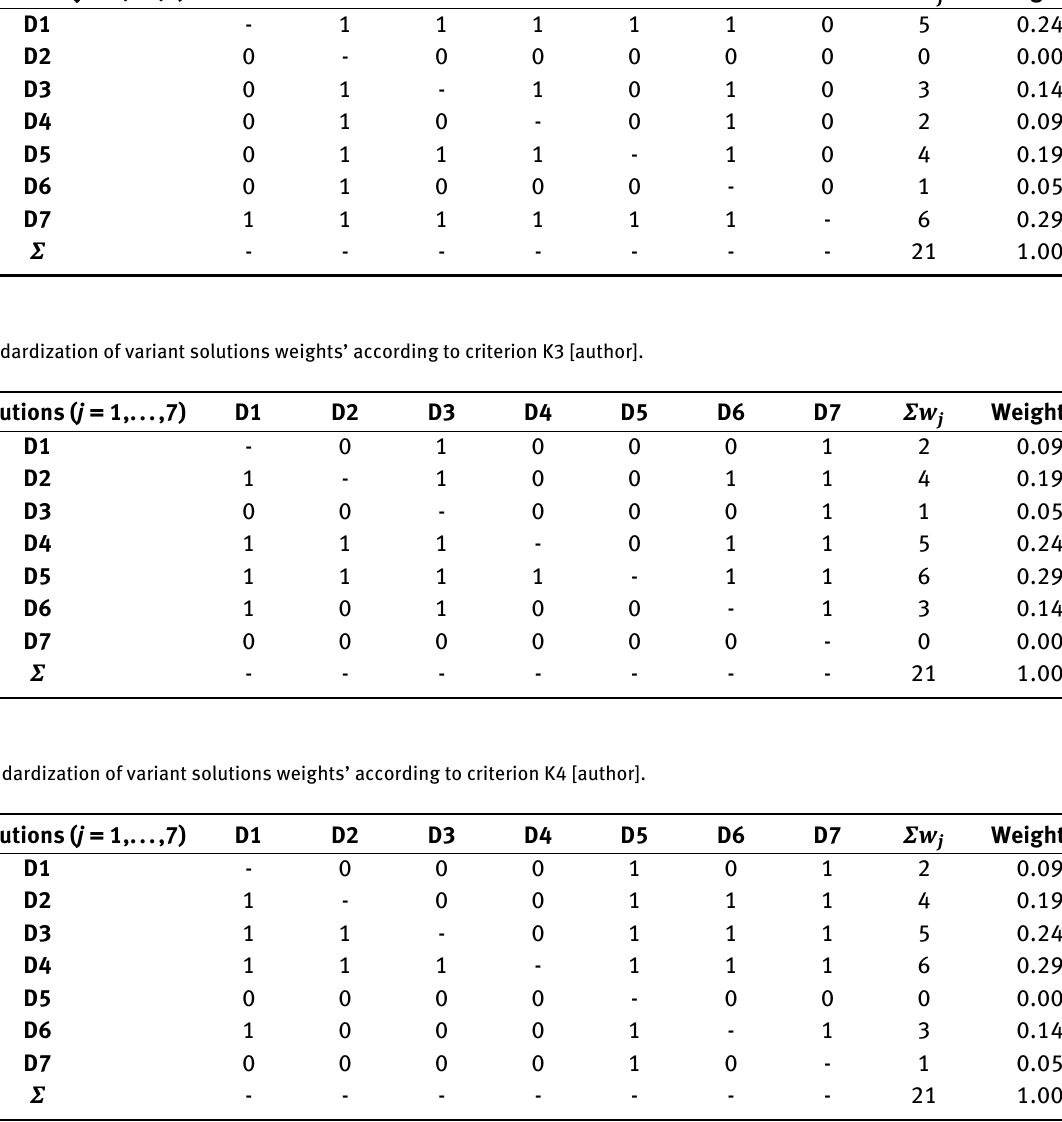
Table 4: Standardization of variant solutions weights’ according to criterion K2 [author]. Variant solutions ( j = 1,...,7)